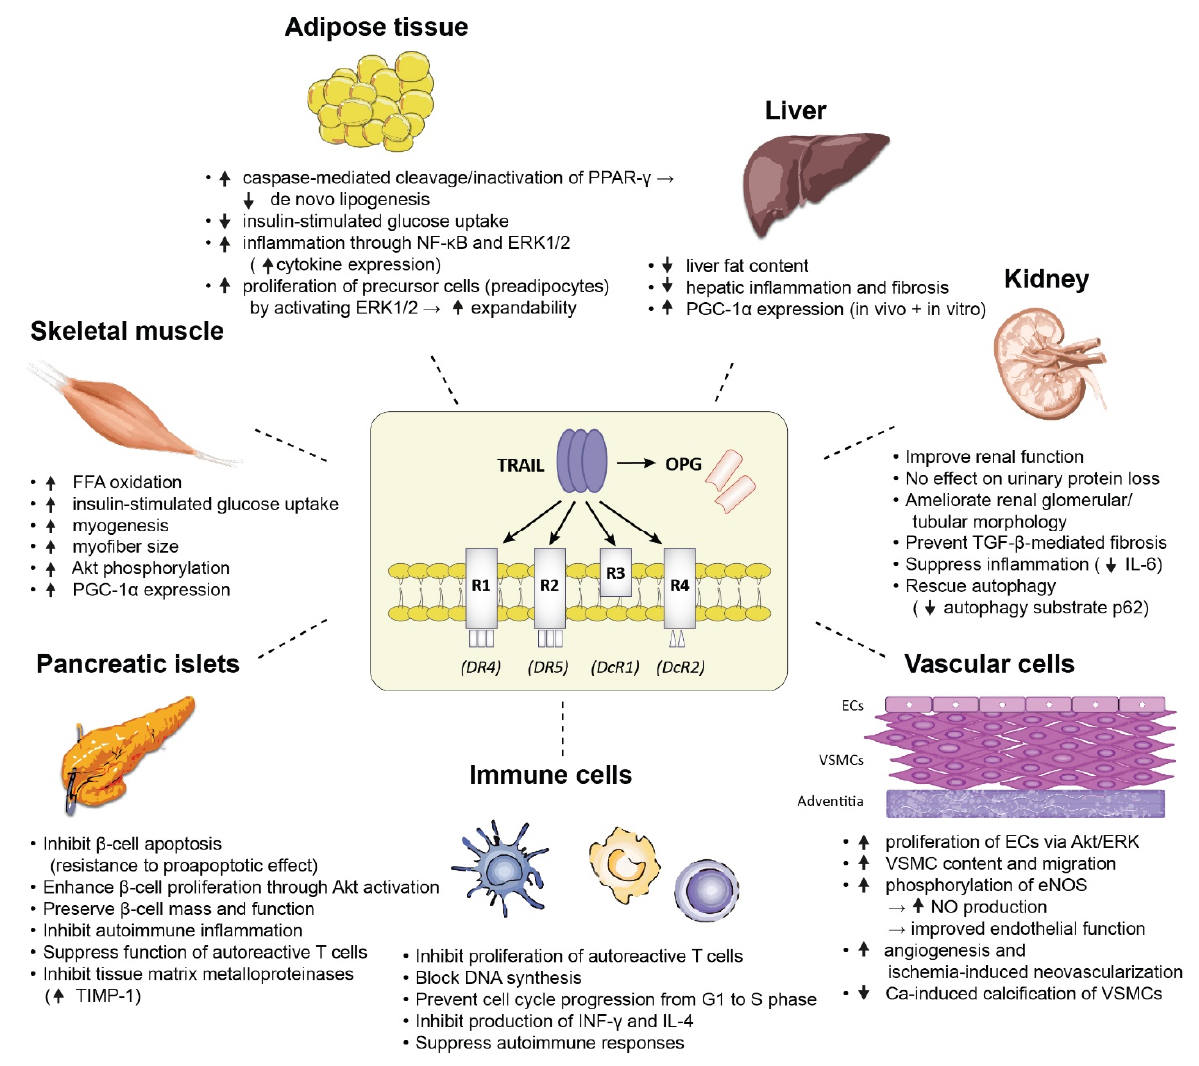
Figure 2. A summary of the major biological effects of TRAIL on a variety of tissues which are pathogenetically involved in the development of diabetes, as demonstrated in animal and in vitro mechanistic studies. Abbreviations: Akt: protein kinase B; ECs: endothelial cells; eNOS: endothelial nitric oxide synthase; ERK1/2: extracellular signal regulated kinases 1 and 2; FFA: free fatty acid; IL-4: interleukin-4; IL-6: interleukin-6; INF- γ : interferon- γ : NF- κ B: nuclear factor kappa B; NO: nitric oxide; PGC-1 α : peroxisome proliferator-activated receptor γ co-activator-1 α ; PPAR- γ : peroxisome proliferator-activated receptor γ ; TGF- β : transforming growth factor- β ; TIMP-1: tissue inhibitor of metalloproteinase 1; VSMCs: vascular smooth muscle cells